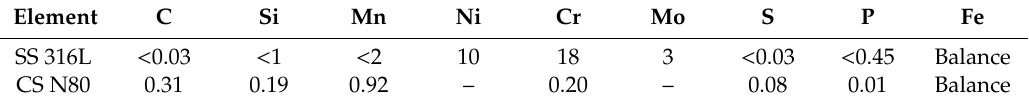
Table 1. Nominal composition of stainless steel AISI 316L and carbon steel N80 used as substrates.